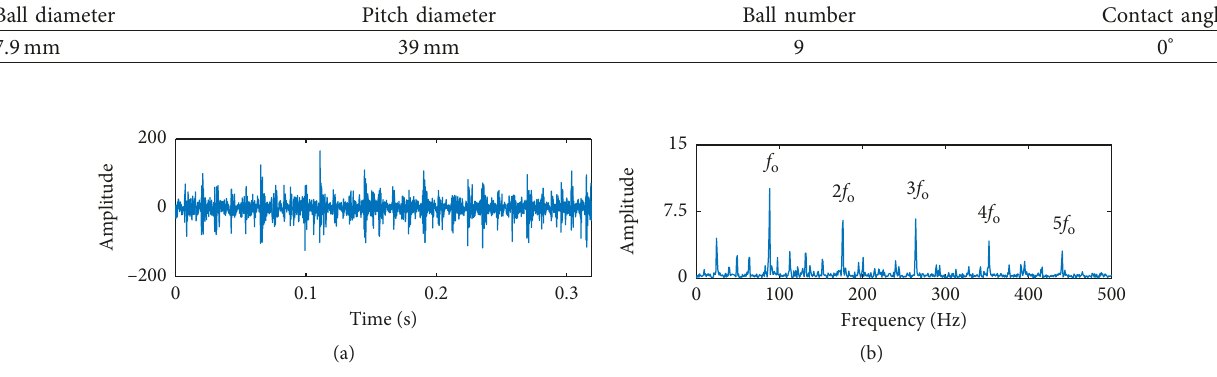
Figure 15: The compound fault experimental signal: (a) TW; (b) ES.